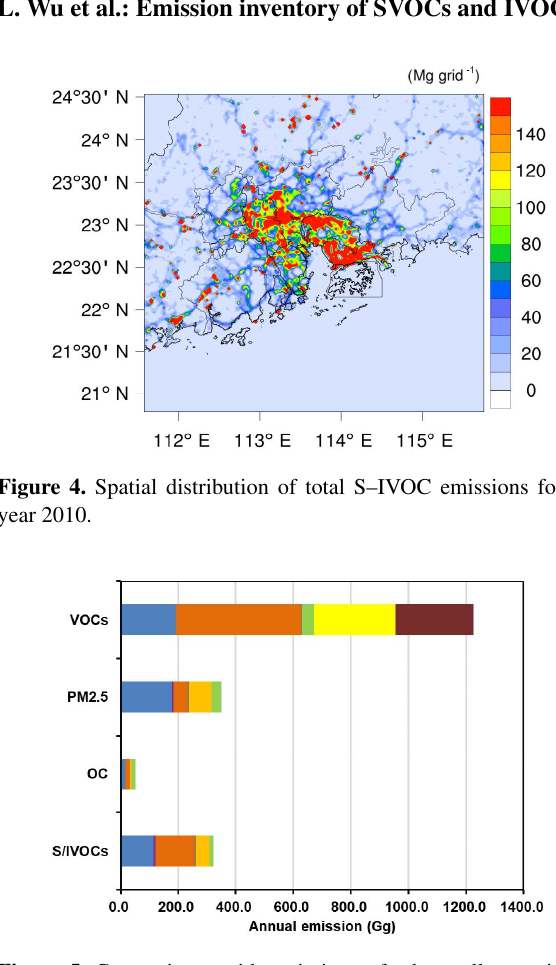
Figure 5. Comparisons with emissions of other pollutants in the PRD region for the year 2010.